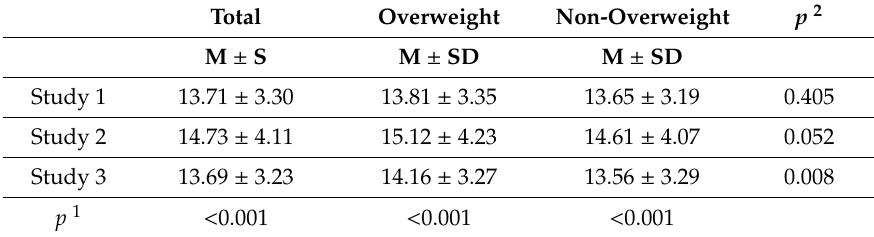
Table 3. Health Behavior Index (HBI) change in 3 study periods by the body weight status.